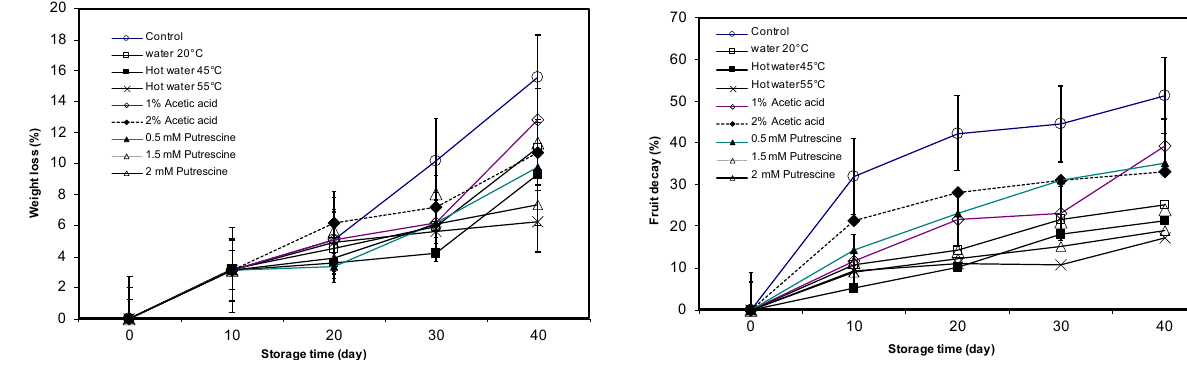
Figure 1. Mean weight loss (± standard deviation; n = 3) of cv. Shahrodi apricots before and during storage for 40 d at 5°C follow- ing different treatments.